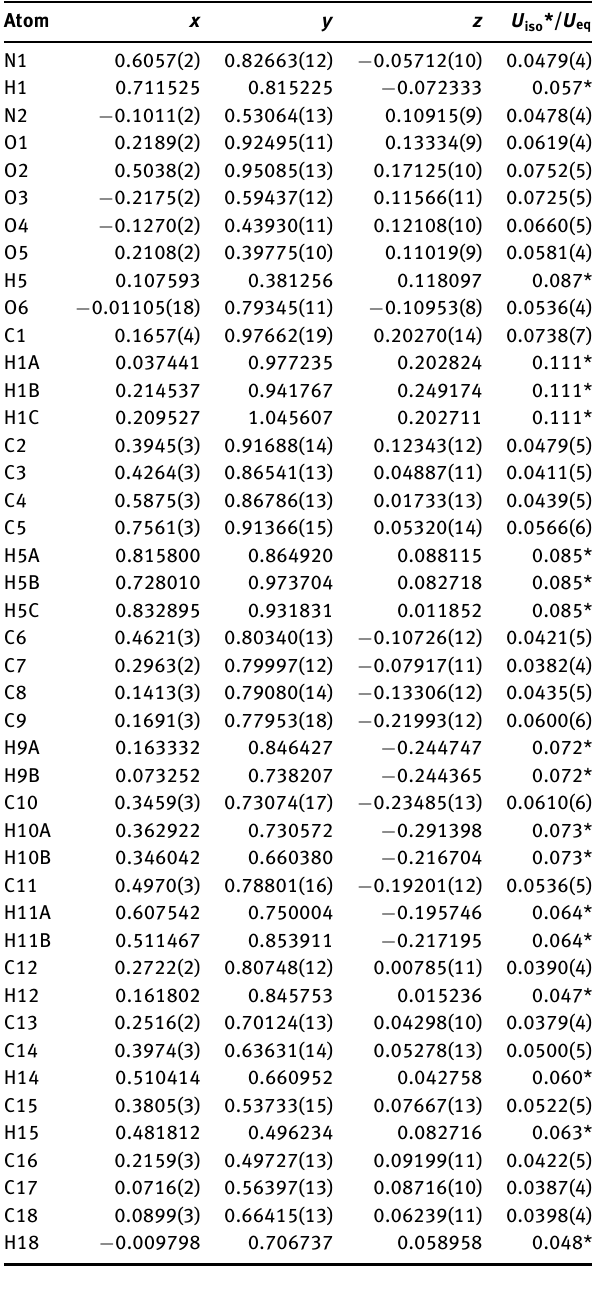
Table 2: Fractional atomic coordinates and isotropic or equivalent isotropic displacement parameters (Å 2